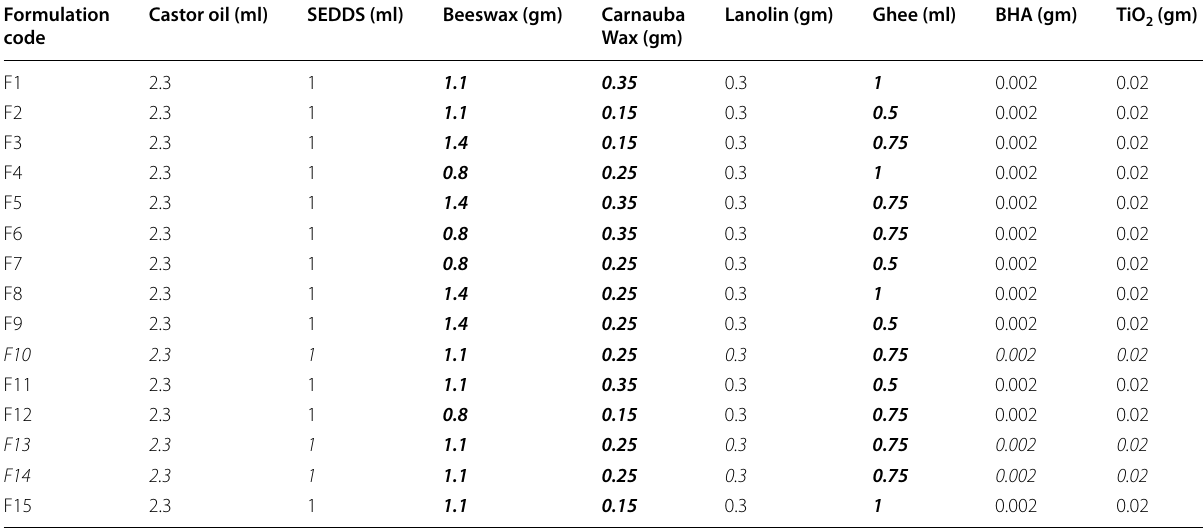
*Rows highlighted in italic represent the central values of experimental design, while columns indicated by bolditalic background are independent factors